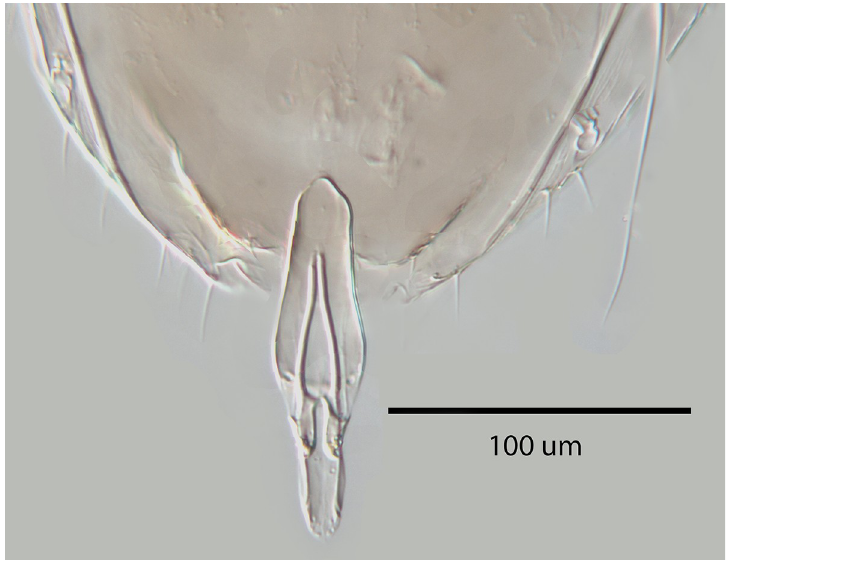
Fig 13. M . macadamiae male genitalia.